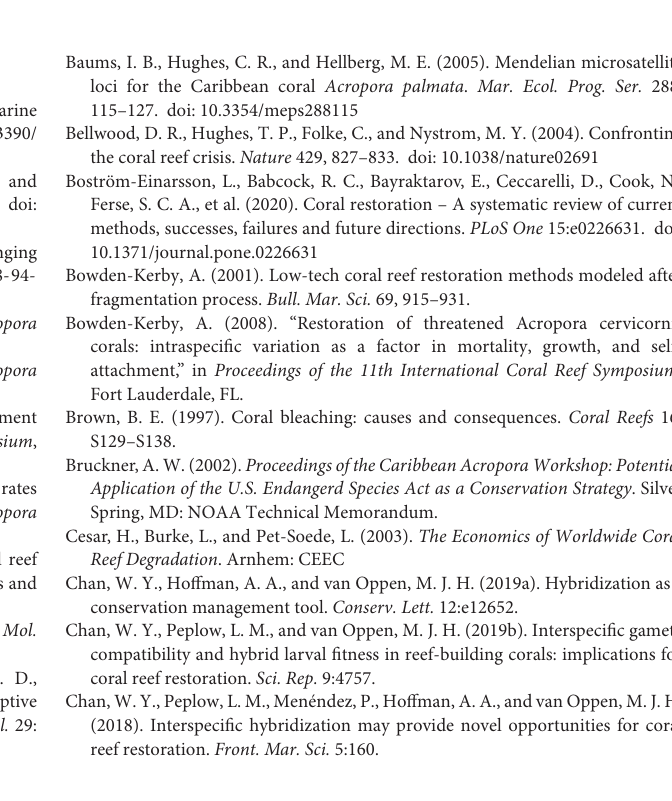
Supplementary Table 2 | Monthly temperature ranges ( ◦ C) from June 2018 to July 2019. Supplementary Table 3 | GPS coordinates for nursery